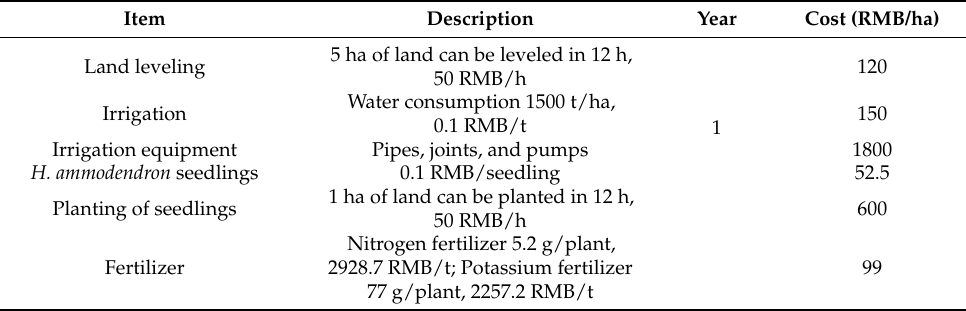
Table 1. Preparation costs for planting H. ammodendron (C.A.Mey.) Bunge